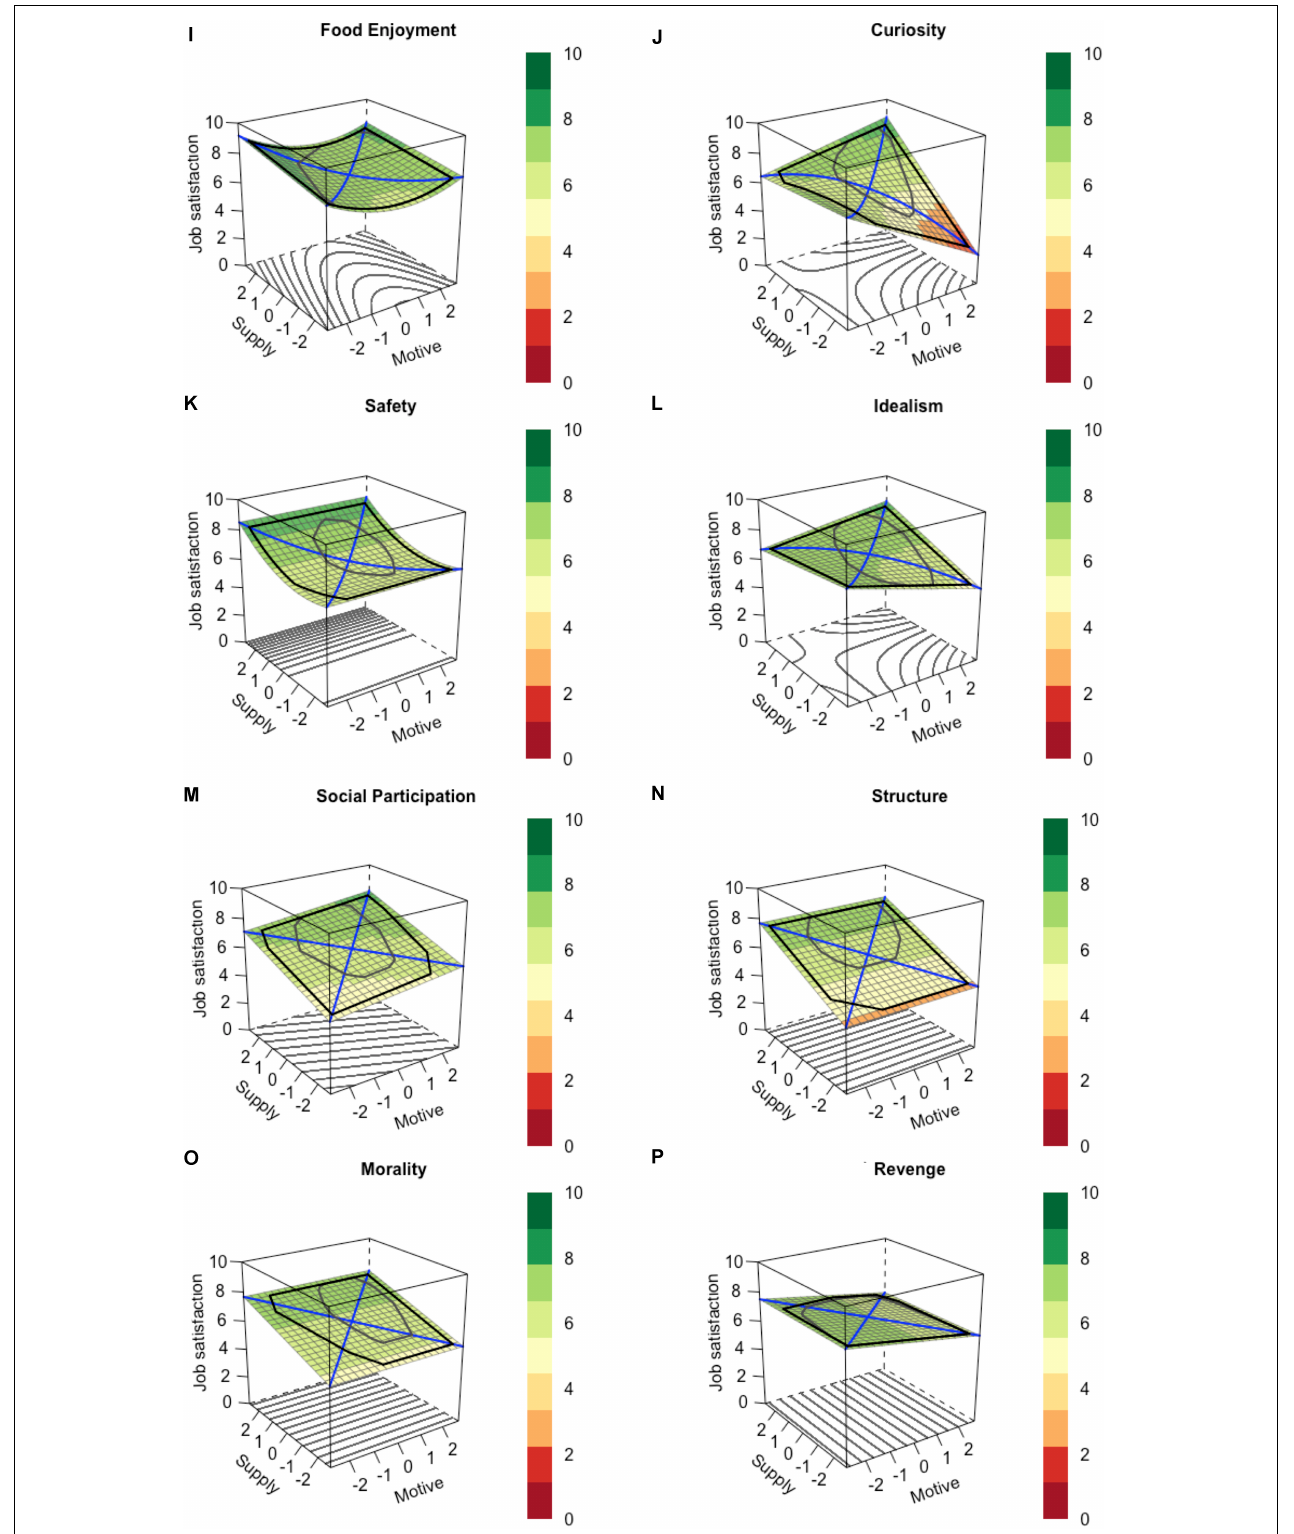
FIGURE 2 | Response surfaces for (A) Social Acceptance, (B) Status, (C) Autonomy, (D) Sex, (E) Retention, (F) Dominance, (G) Family, (H) Physical Exercise, (I) Food Enjoyment, (J) Curiosity, (K) Safety, (L) Idealism, (M) Social Participation, (N) Structure, (O) Morality, and (P) Revenge. Higher numbers represent higher levels. The bold line projected on the surface indicates the interpretable region such that only the area inside this line should be interpreted.